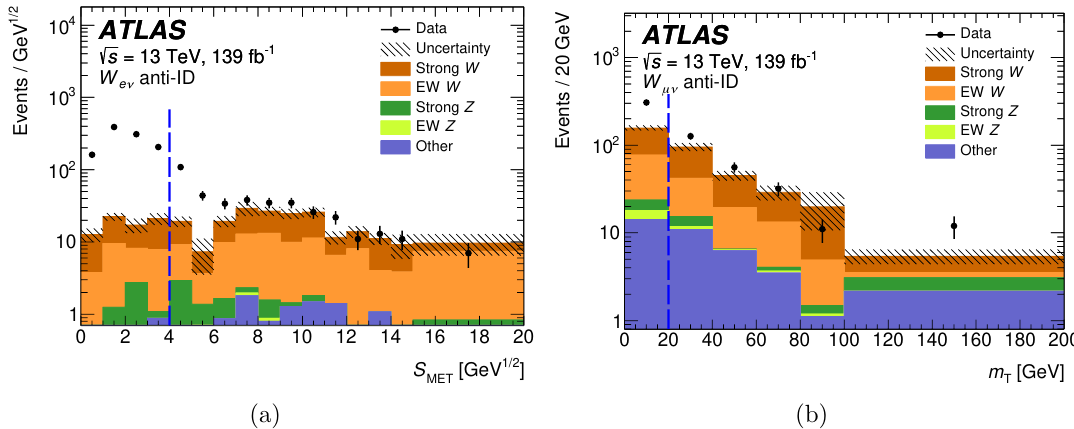
Figure 4. The figure labelled (a) shows a comparison of the S MET distribution in data and simulation for the W anti-ID control region, for which the electron passes a loose identification eν criterion but not the tight one. The figure labelled (b) shows a comparison of the transverse mass m T distribution in data and simulation for the W µν anti-ID control region, for which the muon candidate does not pass the loose identification criterion. Minor contributions from t ¯ t , V V , V V V , and VBF H with H → τ + τ − or H → WW ∗ are combined and labelled ‘other’. The excesses in data, observed at low S and low m values, are caused by multijet events containing a fake lepton. MET T The hashed bands display the combined uncertainty from MC sample sizes and experimental